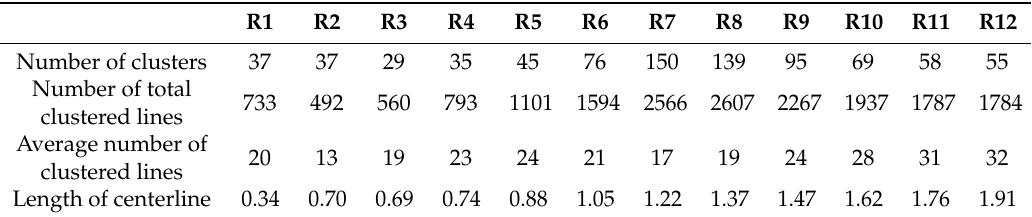
Table 2. Features of the clusters with different fixed